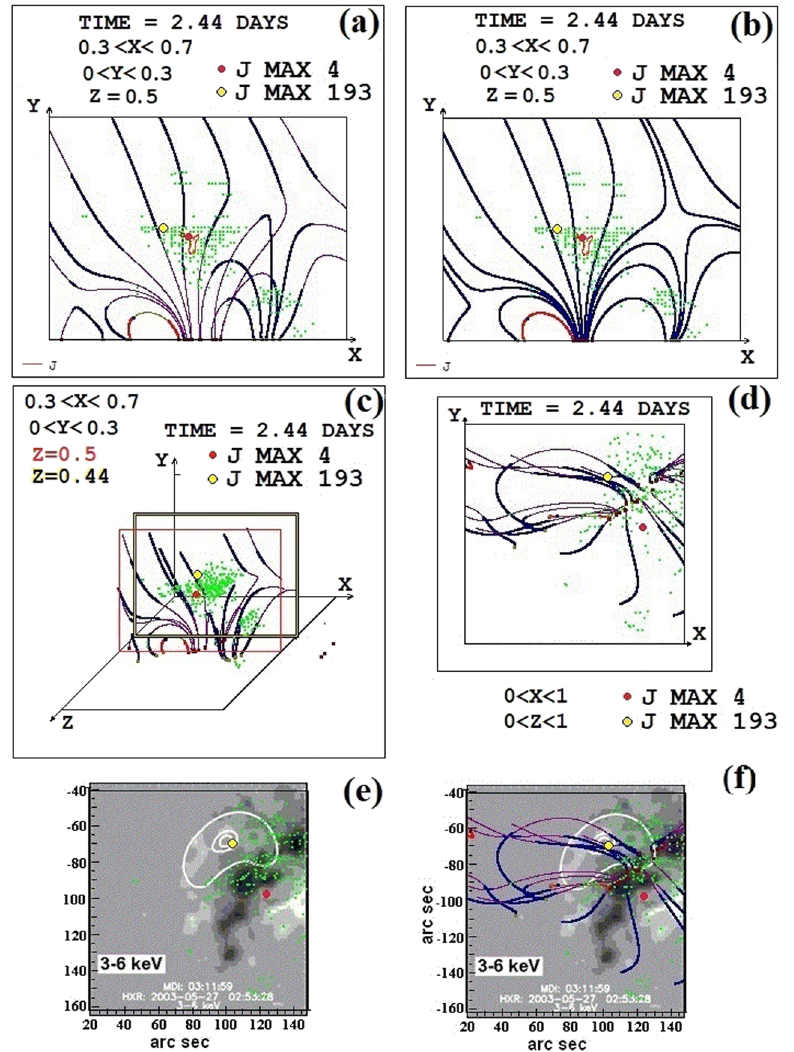
Figure 6: The con fi guration of the magnetic fi eld in the main part of the computational domain with a strong magnetic fi eld, where solar fl ares occur, and overlaying the results of MHD simulation on the distribution of soft X - ray emission of 3 – 6 keV, received by the RHESSI spacecraft during the M 1.4 fl are on May 27, 2003 ( http://rhessidatacenter.ssl.berkeley.edu ) . The 4th and 193rd maxima of the current density are marked; other current density maxima are shown by green points. ( a ) Projections of magnetic lines on the central plane of the computational domain . ( b ) Plane magnetic fi eld con fi guration is represented by lines tangent to the projections of the magnetic fi eld vectors on the central plane. ( c ) 3D con fi guration of the magnetic fi eld in the region